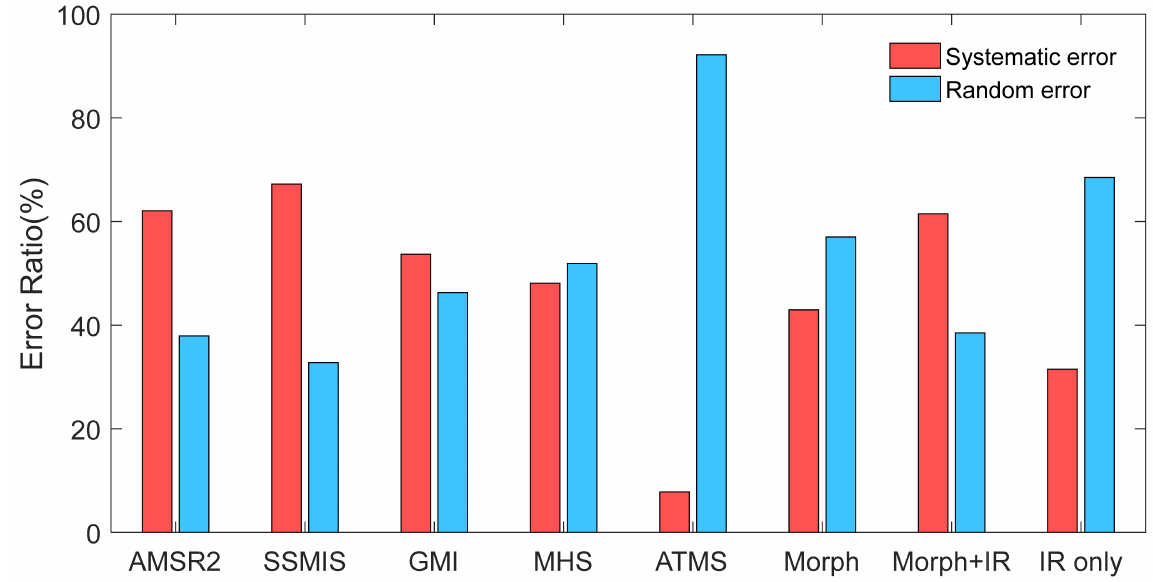
Figure 8. The systematic and random error for each input source used in